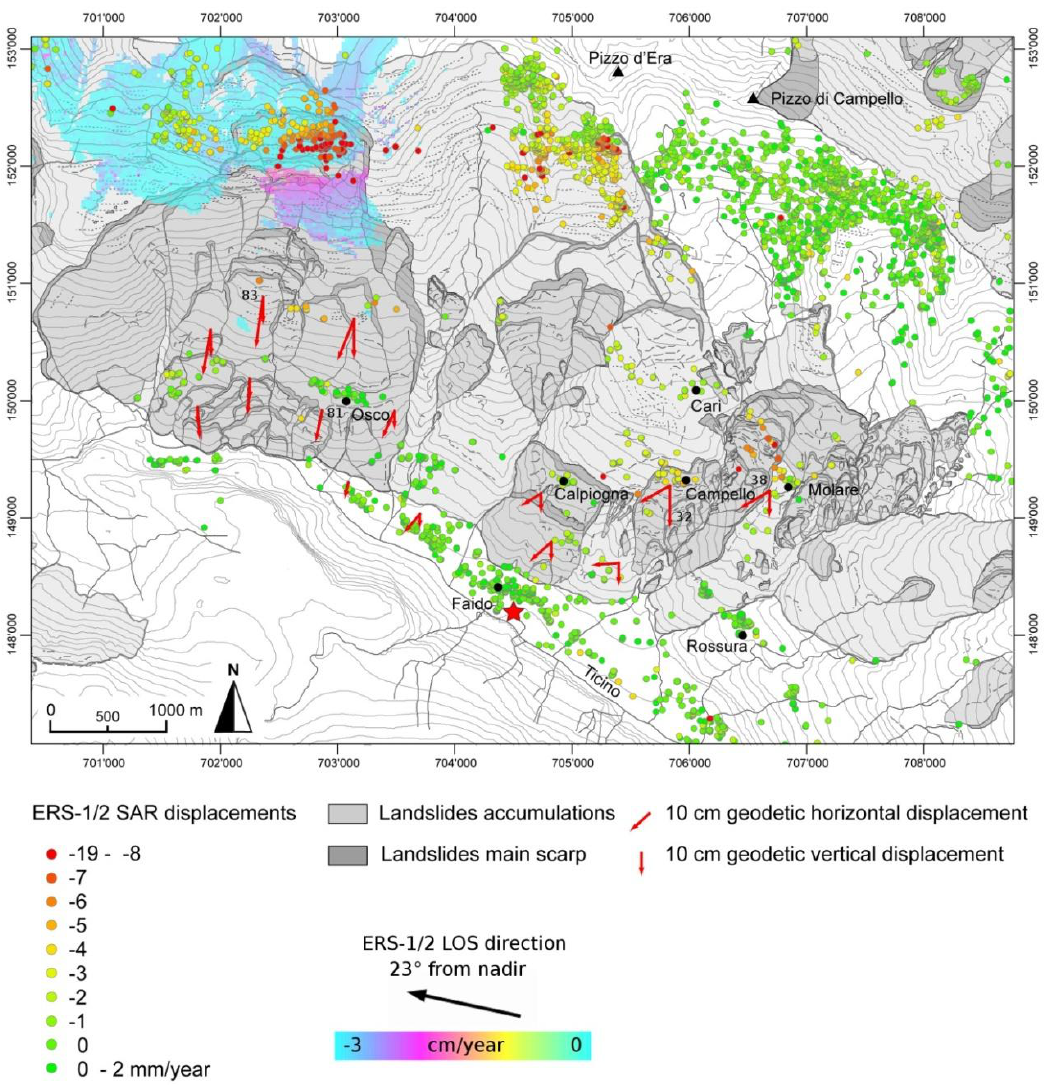
Figure 4. Average displacement rates of point targets in the satellite LOS direction from ERS-1/2 SAR data for the time period 1992–2000, plotted on the sketch map with geomorphological features. Negative values indicate an increase in the distance from target to satellite; the red star indicates the location of the reference point. The displacement map from the ERS-1/2 SAR interferogram 1996.07.26–1997.08.15 is also shown using a different color scale for the western-upper part of the slope. The vectors indicate the horizontal and vertical displacements of some geodetic points determined with classical trigonometric techniques between 1992 and 2000. The numbers indicate the benchmarks of the profiles discussed in Section